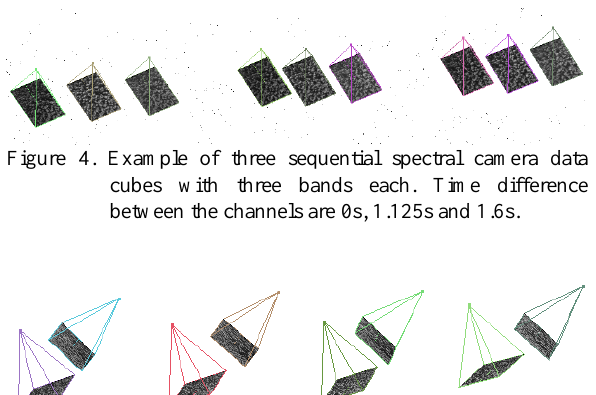
Figure 3. Example of oblique image captured with the spectral camera. One channel image.